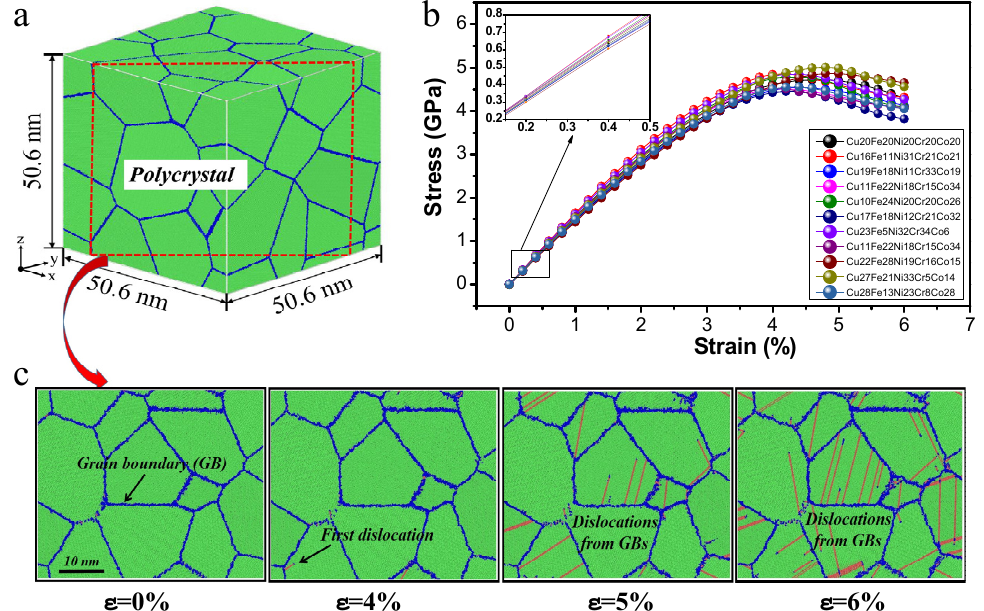
Figure 7. ( a ) Atomic configuration of the polycrystal ample. The sample contains 16 randomly orientated grains, and the mean grain size is 27.4 nm. ( b ) Stress-strain response of the polycrystal HEA samples with different element compositions. ( c ) Snapshots of the polycrystal sample Cu 28 Fe 13 Ni 23 Cr 8 Co 28 at different deformation stages (cross-sectional view along [110] direction). Atoms are coloured by the CNA method. The green atoms are located in the grain with fcc structure, while the blue atoms are located at the grain boundary region, and the red atoms represent the stacking faults created by the slip of the nucleated dislocations from grain boundaries.